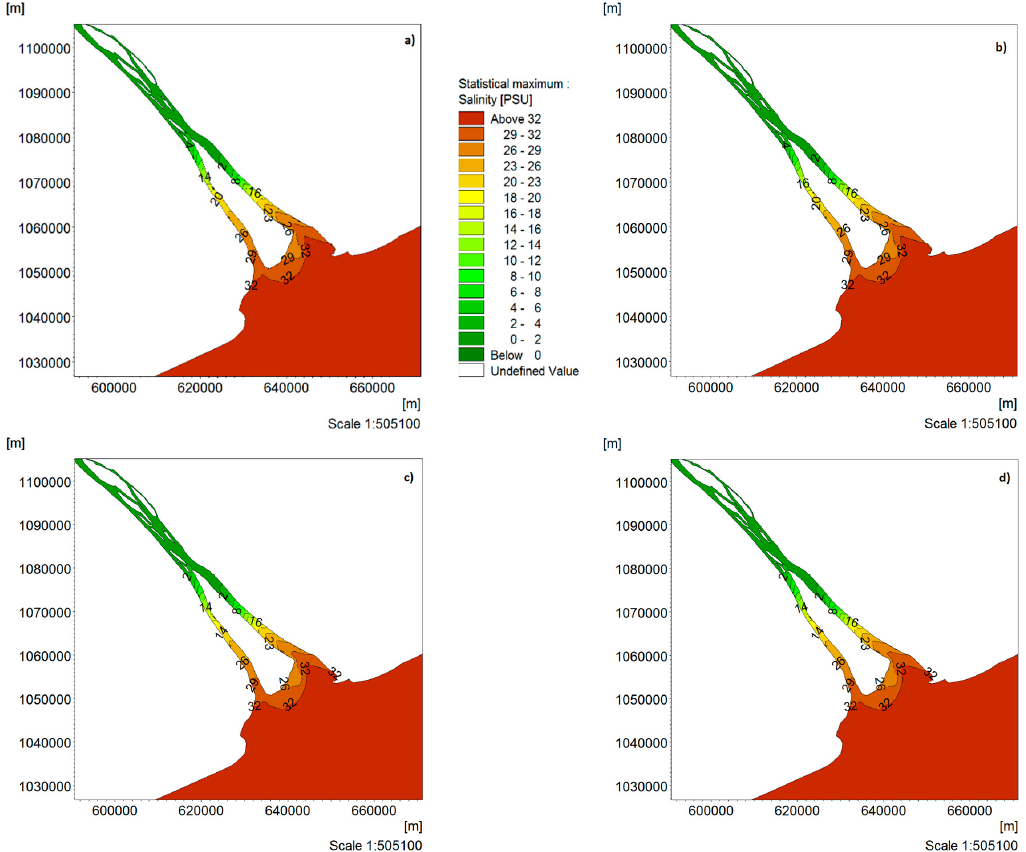
Table 8. The relative change of salinity intrusion length for four scenarios compared to baseline.